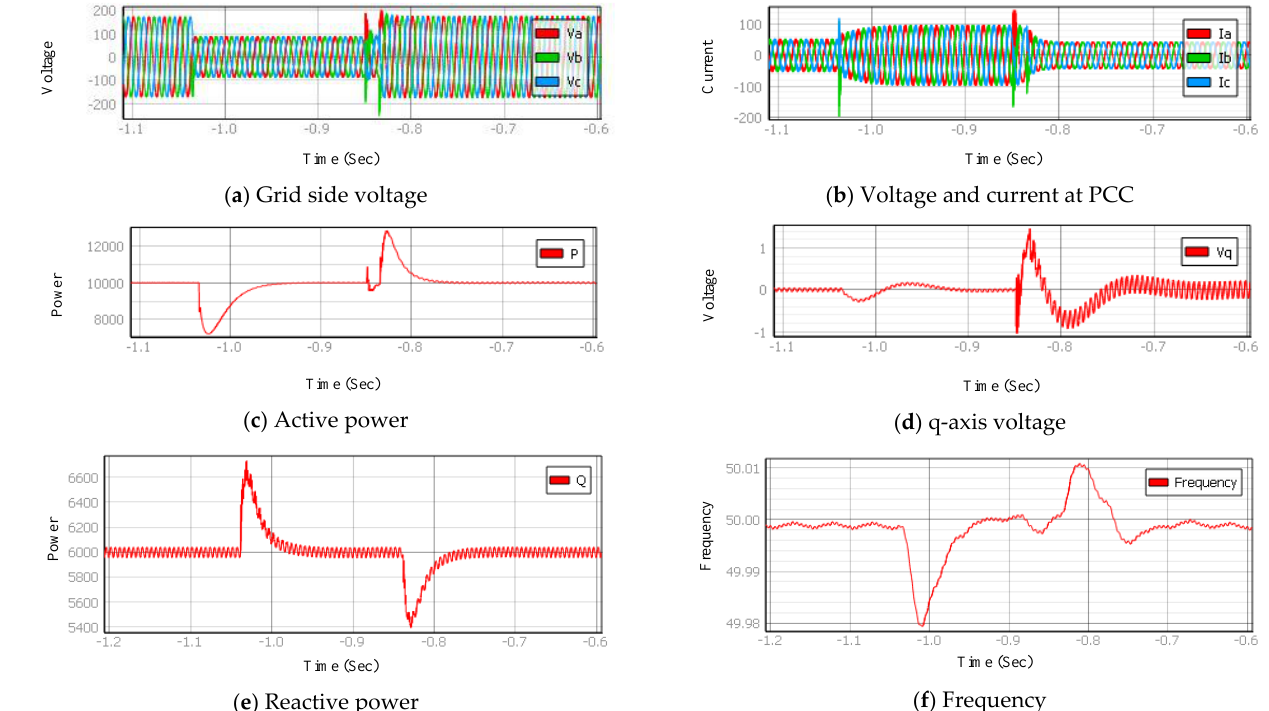
Figure 15. Characteristics of the DG system during islanding operation.